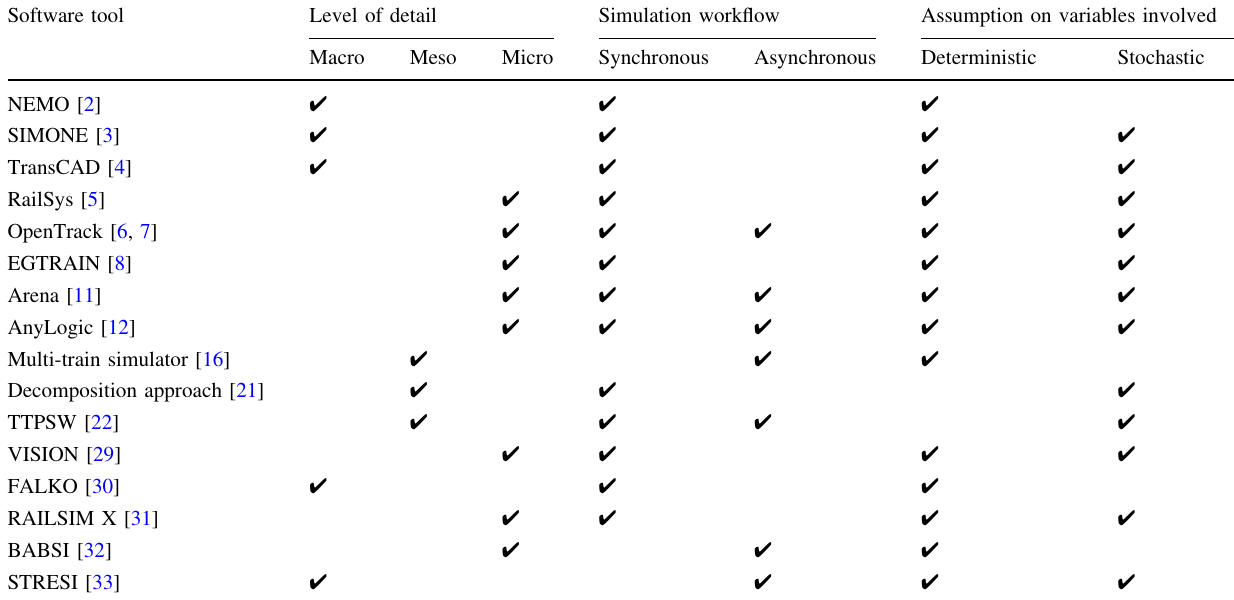
Table 1 Classification of rail simulation software tools: an overview